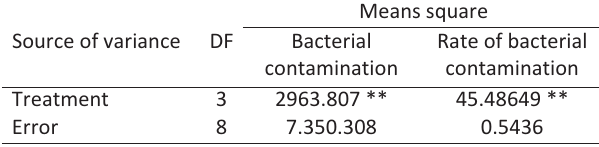
Table 1 ­ Analysis of variance traits under study